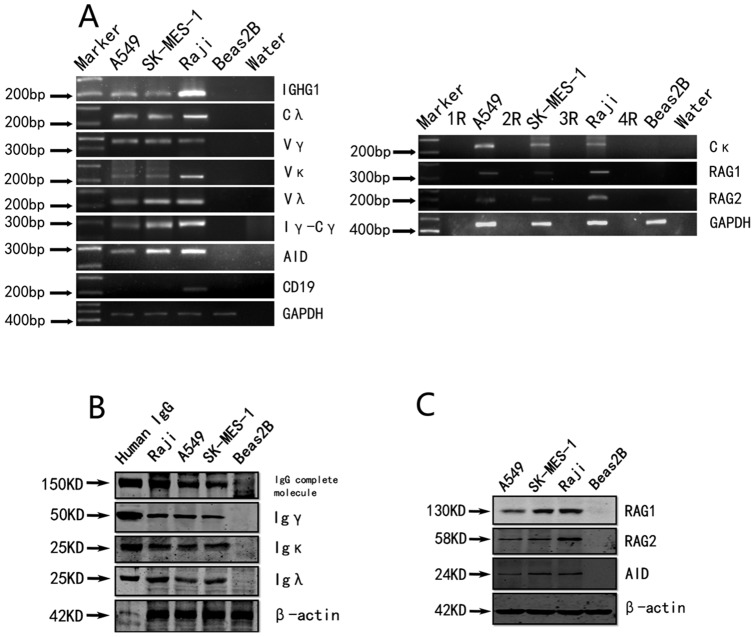
IgG expression in lung cancer cell lines with RT-PCR and Western blot.
A, the bands represented that IgG synthesis associated genes were detected with RT-PCR in A549 and SK-MES-1, whereas not in Beas2B. B shows that IgG whole molecule, Igγ, Igκ and Igλ are detected in A549, SK-MES-1, whereas not in Beas2B with Western blot. Human pure IgG was used as molecular weight standard to compare with that from lung cancer cells. Raji cell line was a positive control. C shows that RAG1, RAG2 and AID are expressed in lung cancer cells, whereas not in Beas2B. Raji cell line was served as a positive control.